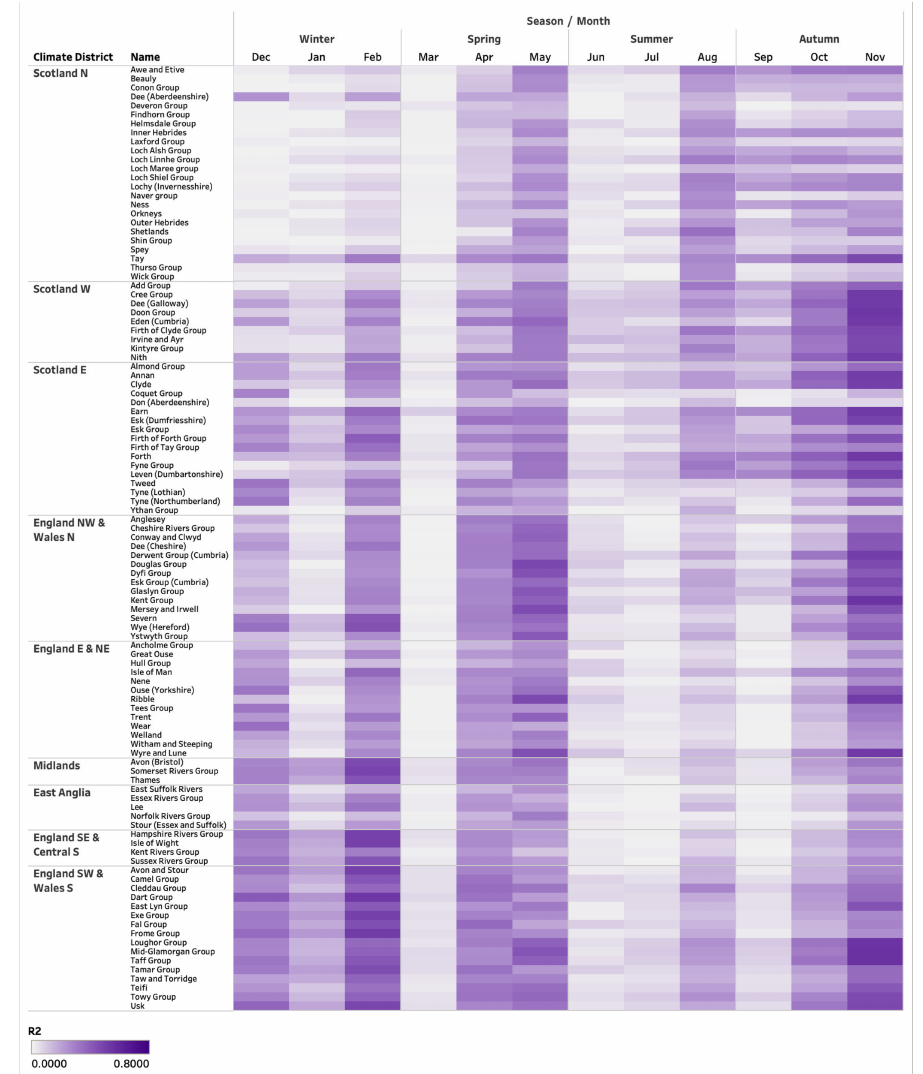
Figure 3. R 2 values of the univariate regression model exploring the relationship between the EA index and SPI-1 values across the IHU